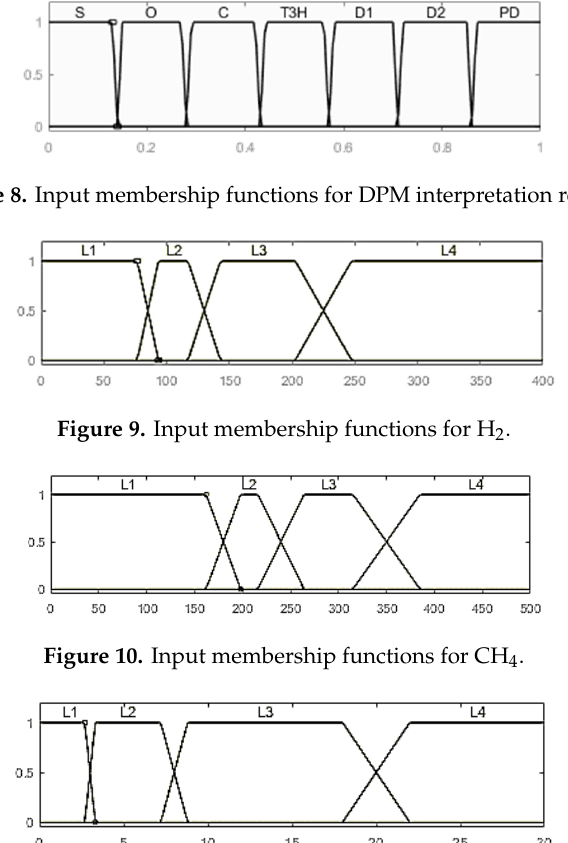
Figure 10. Input membership functions for CH 4 . Figure 11. Input membership functions for C 2 H 2 . Energies 2020 , 13 , 1009 14 of 20